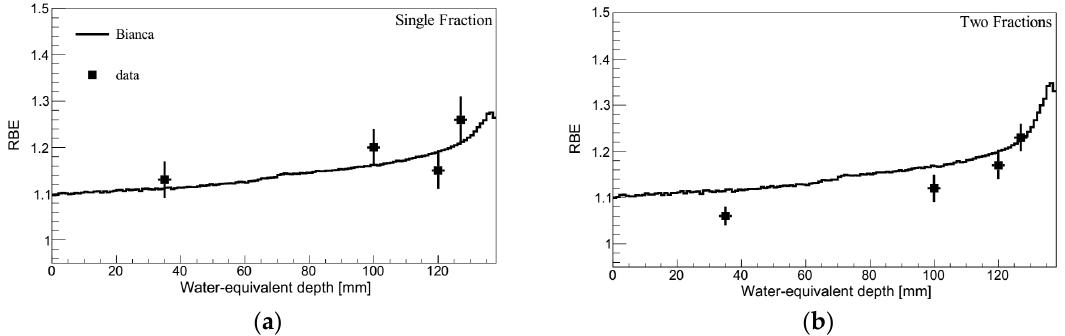
Figure 4. RBE as a function of depth for single-fraction (panel a ) or two-fraction (panel b ) proton irradiation of the rat spinal cord. The lines are predictions by BIANCA, the points are experimental data taken from [15].